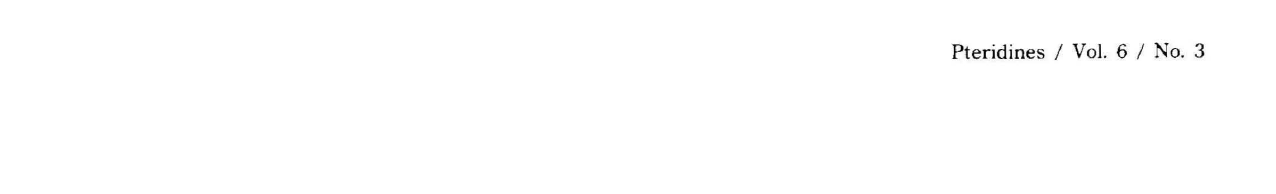
DH. (Figure lA) and points to a de novo synthesis from GTP. The decline of DH. levels in the medium after a period of 4h - 5h can be explained by a marked increase of pterin deaminase activity during